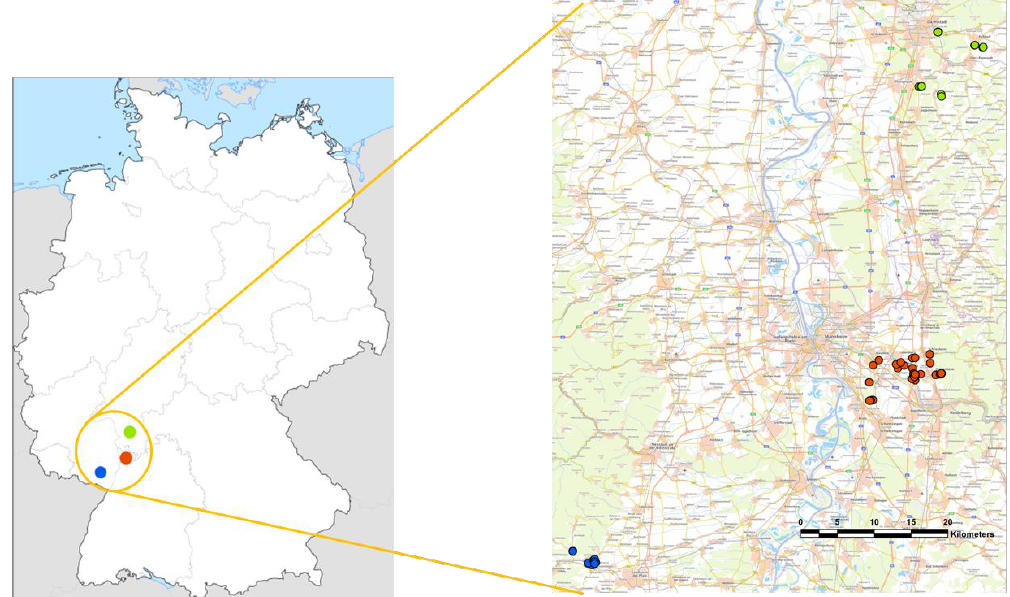
Figure 1. Map of Germany (left) showing the monitoring area (orange inset) and the location of the monitoring traps belonging to each of the three Julius Kühn-Institut (JKI) work groups (red = JKI Dossenheim (Dos), blue = JKI Siebeldingen (Sie) and green = JKI Darmstadt (Dar)). Source: © GeoBasis-DE/BKG 2018.